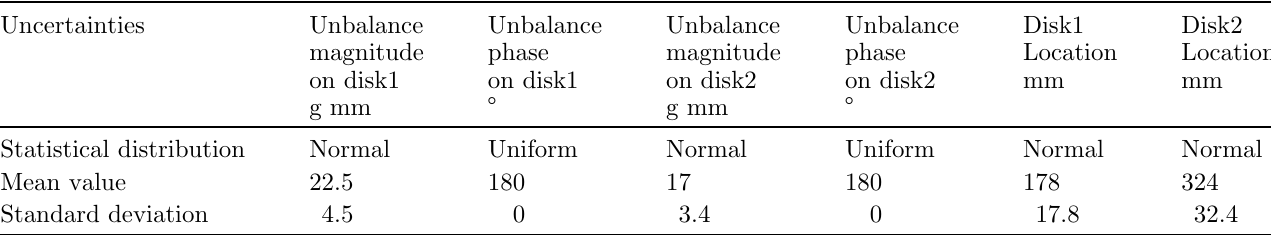
Table 2. Uncertainties considered in uncertain optimization design.